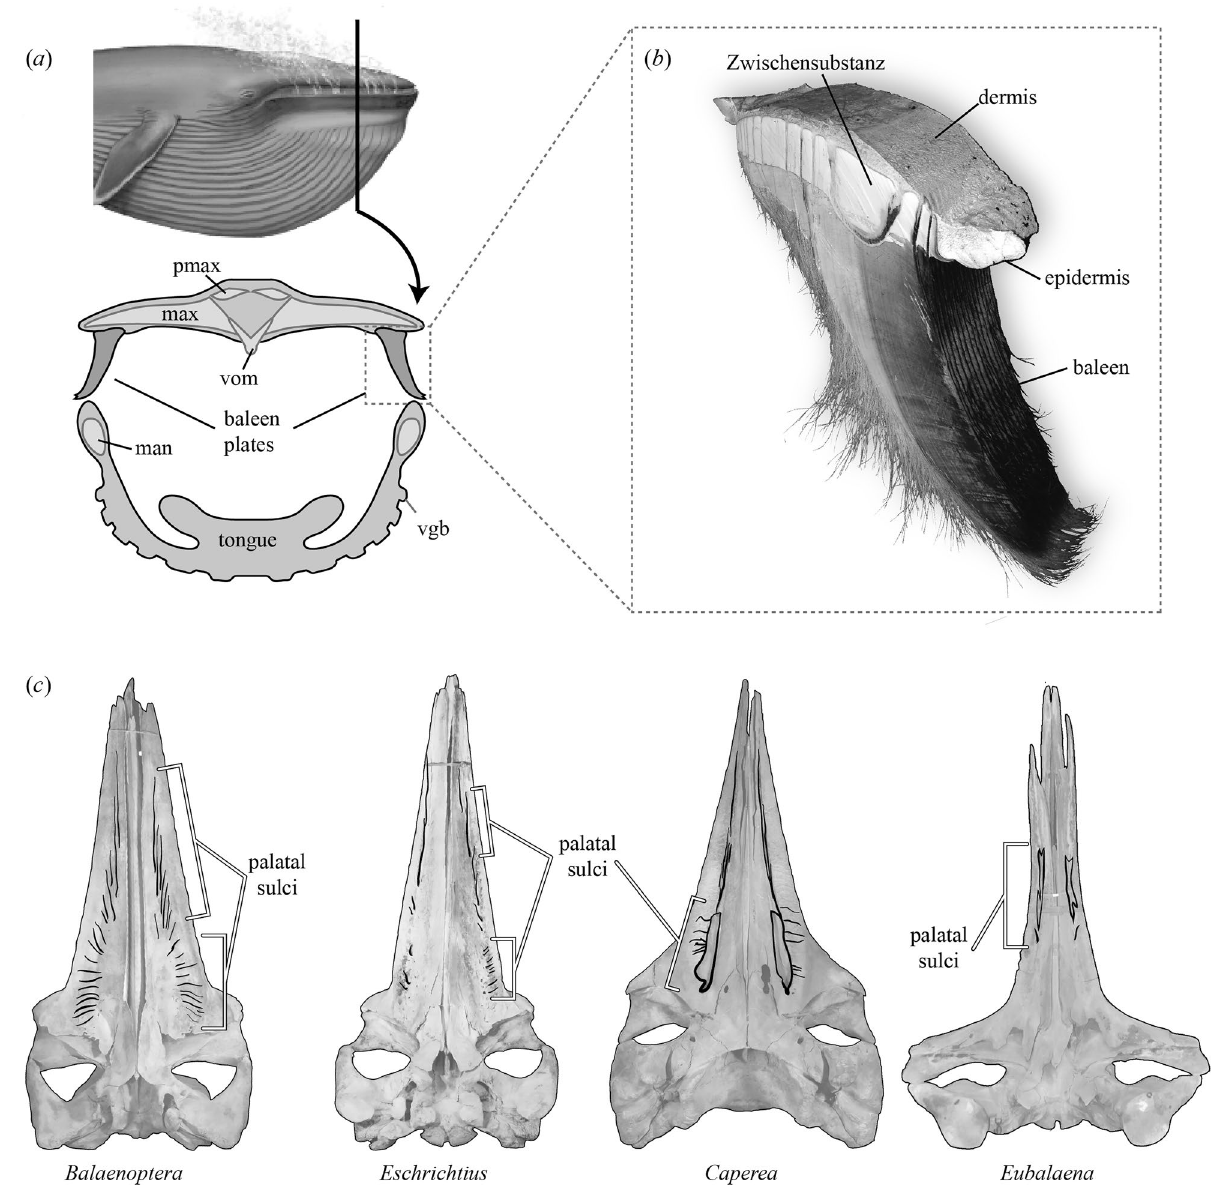
Figure 1. ( a ) Illustration showing the general relationship of the baleen racks, soft tissue, and bony palate. ( b ) Close up photograph highlighting the relationship between zwischensubstanz (baleen mat) and its relationship to the soft tissue ventral to the bony palate in Balaenoptera physalus . ( c ) Palatal morphology of extant mysticetes, from left to right: Balaenoptera borealis , Eschrichtius robustus , Caperea marginata , and Eubalaena glacialis . White brackets surround lateral palatal foramina and their associated sulci. Art by Alex